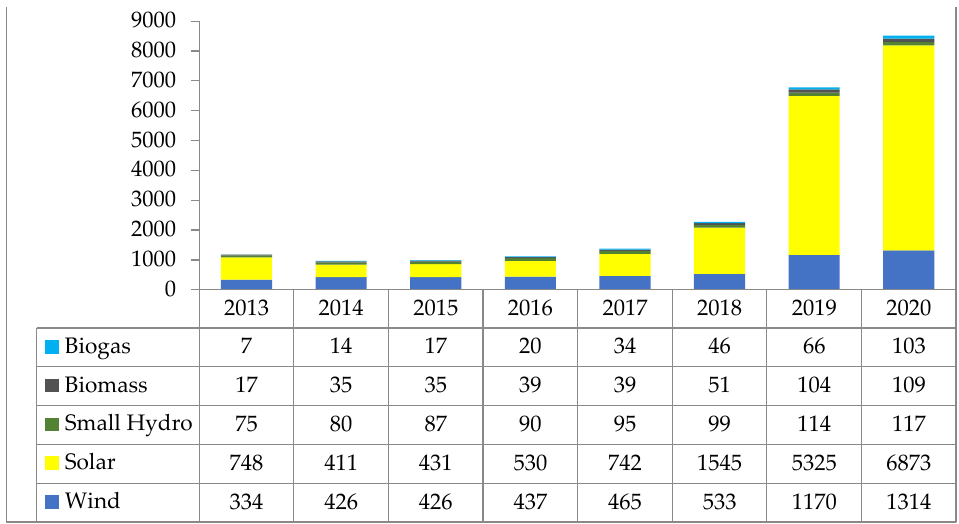
Figure 1. Installed capacities (in MW) of electricity generation facilities based on renewable energy sources in Ukraine [27].